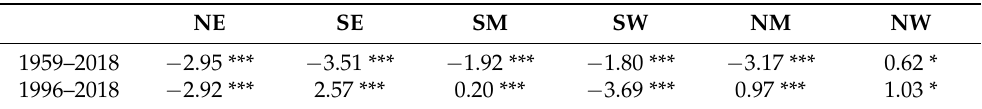
Table 2. The slopes of the lines of the spatially averaged scPDSI values in the six sub-regions in 1959–2018 and 1996–2018. The values are on a scale of 10 − 3